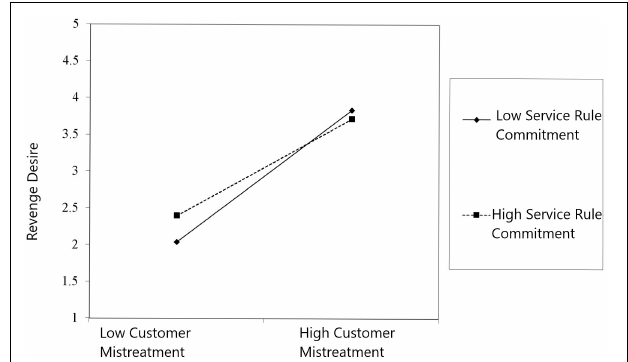
FIGURE 2 | Interactive effect of customer mistreatment and service rule commitment (SRC) on revenge desire.